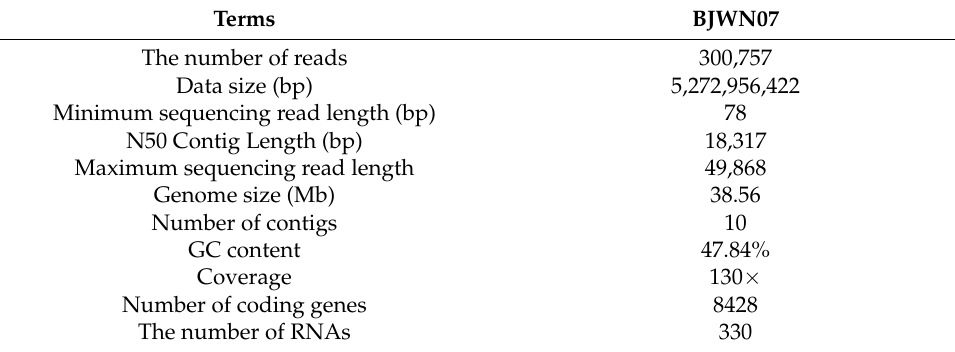
Table 2. Cladobotryum mycophilum BJWN07 genome features.